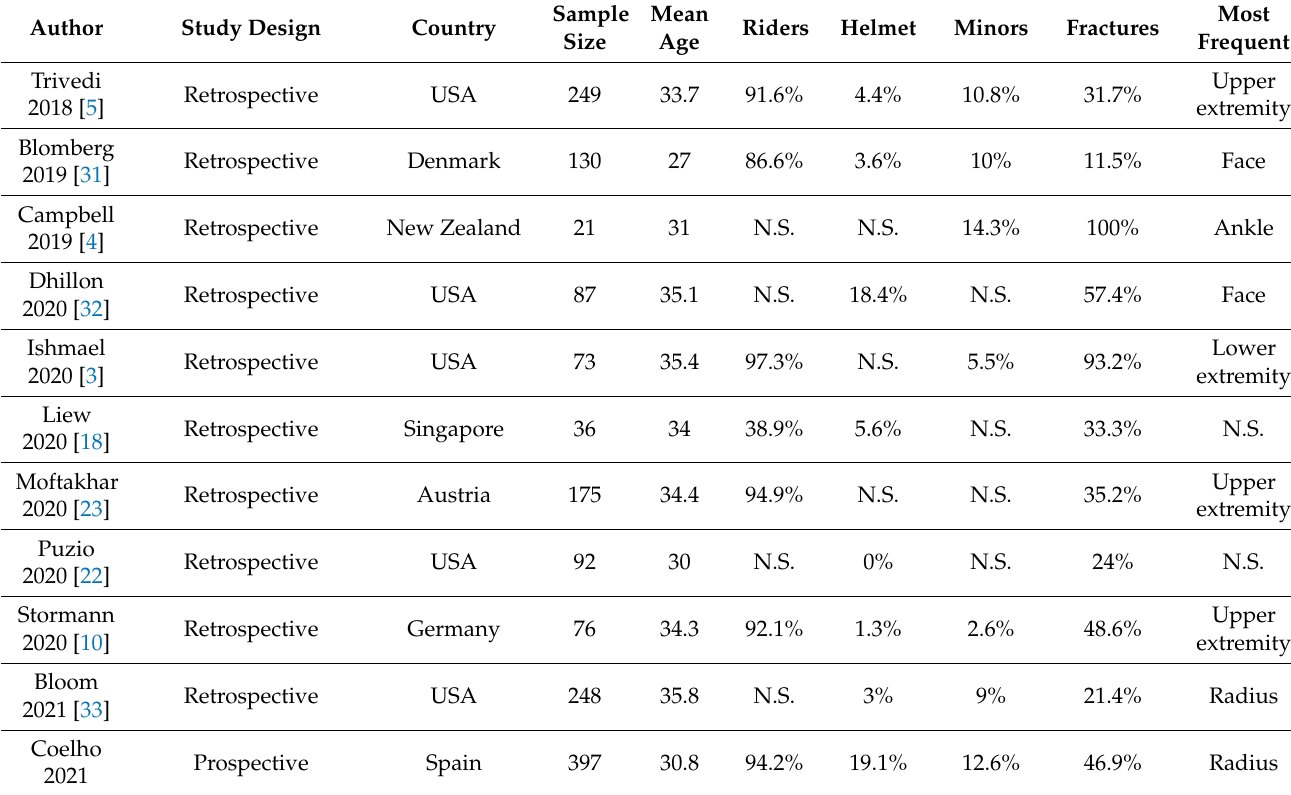
Table 2. Comparison of previous studies reporting injuries after e-scooter